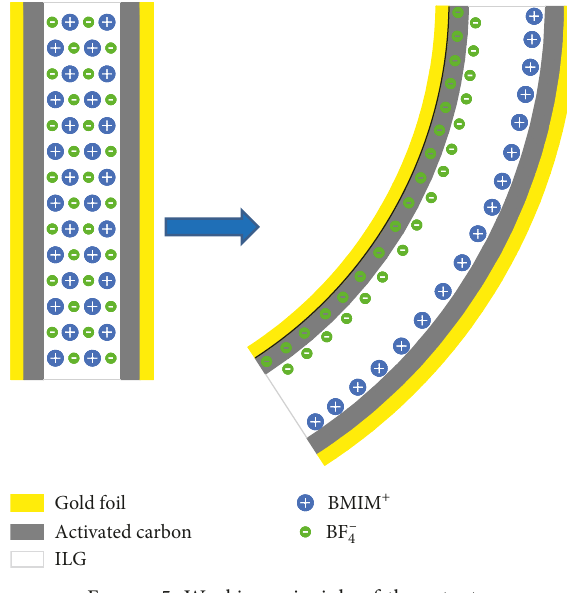
Figure 5: Working principle of the